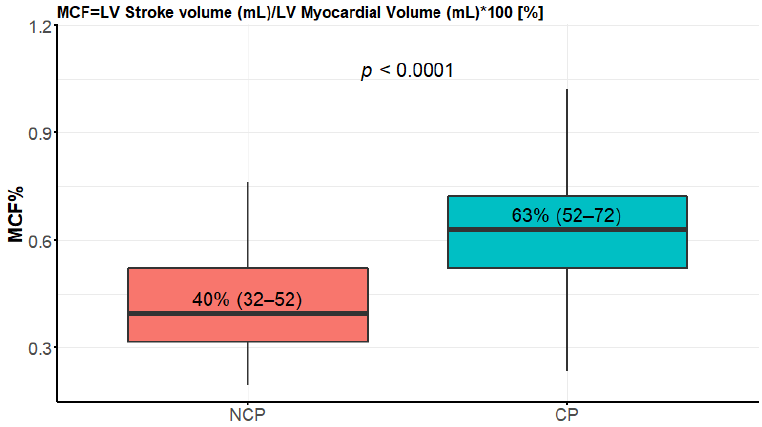
Figure 6. Myocardial contraction fraction comparison between nonclassic and classic phenotypes. Data presented in boxplot as median values, interquartile range, and minimal and maximal values.